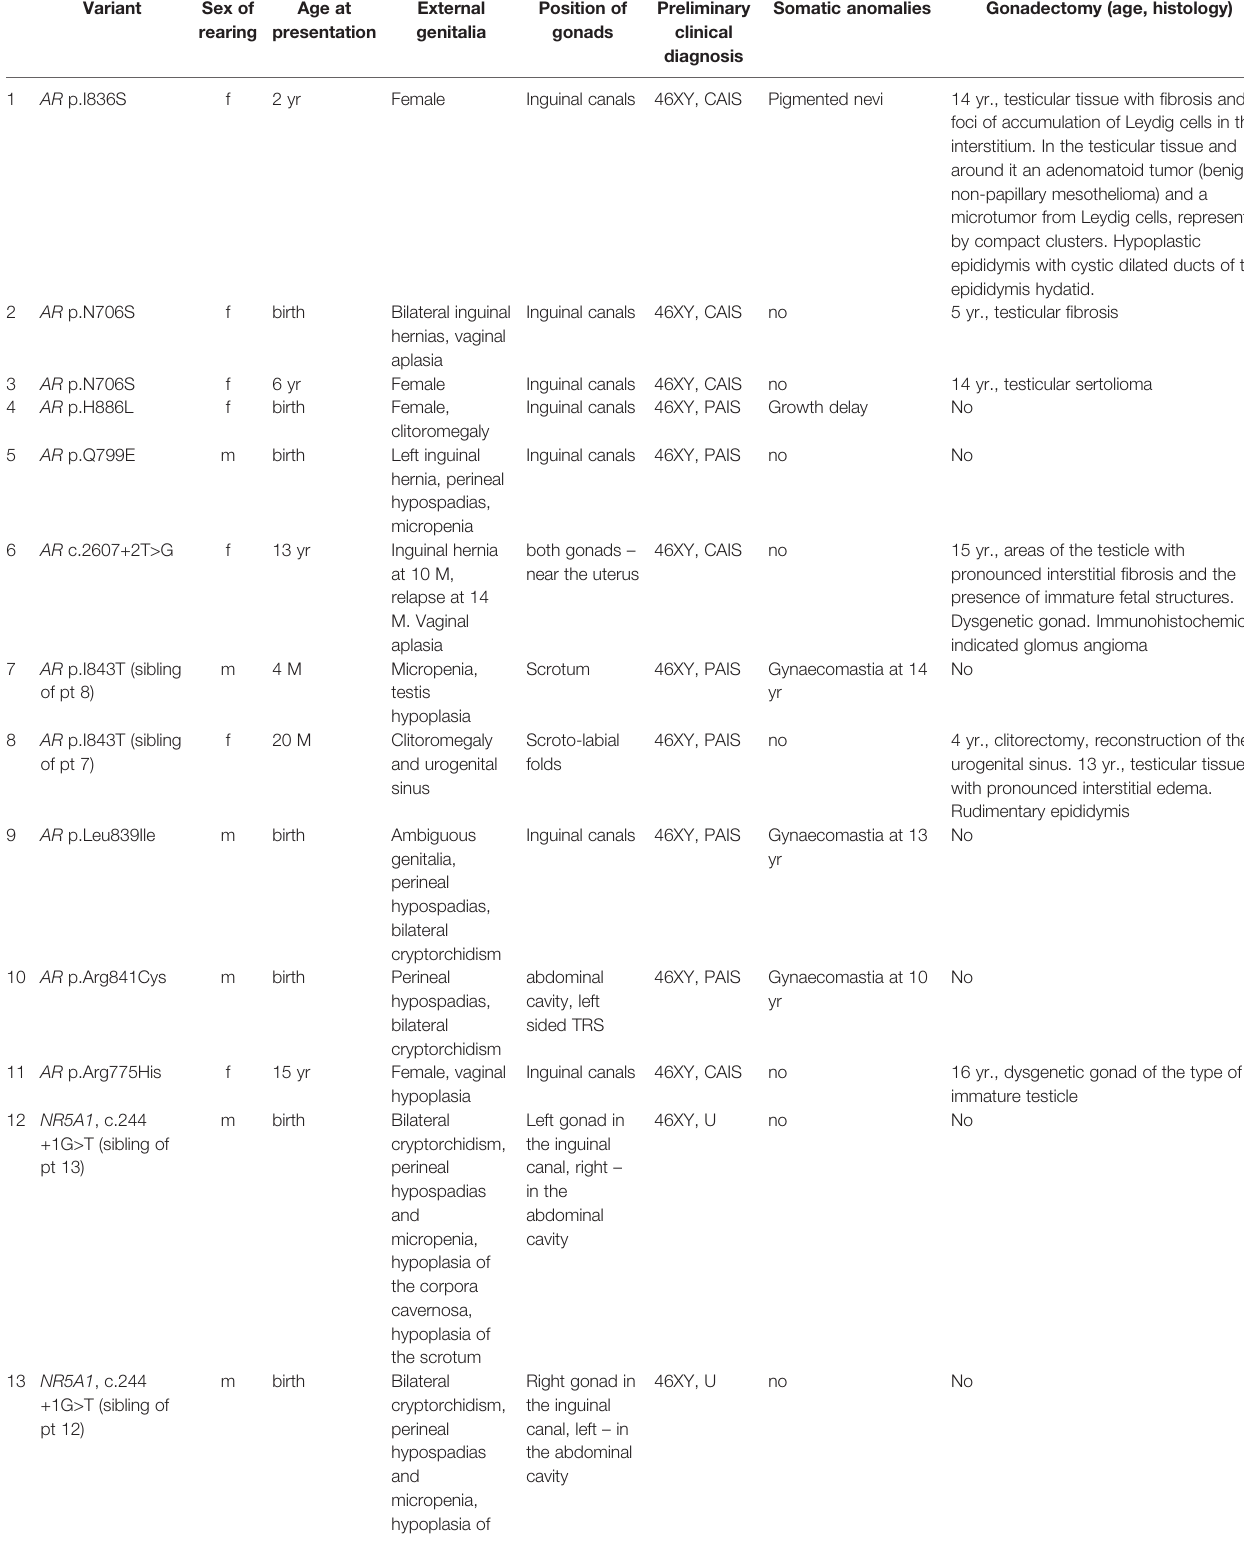
TABLE 1 | Clinical details of the individuals with Pathogenic or Likely Pathogenic variants causing DSD identi fi ed by